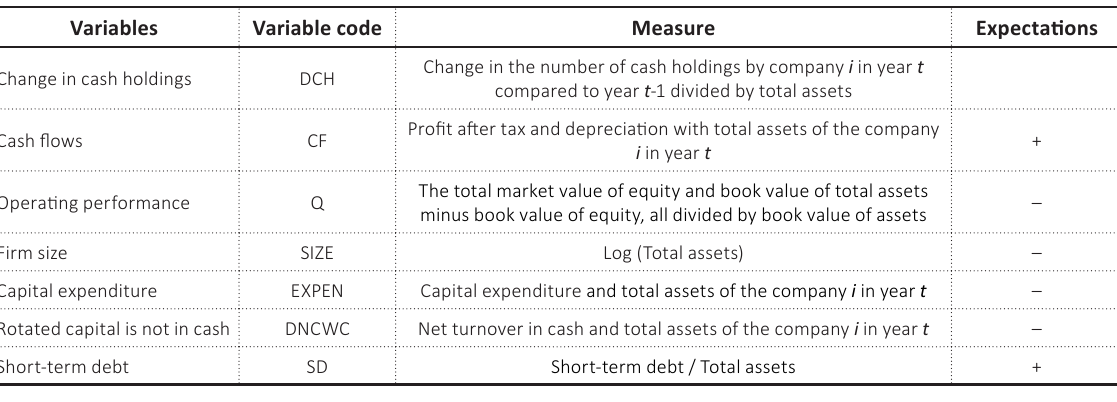
Table 1. Summary of measurement variables in the research model